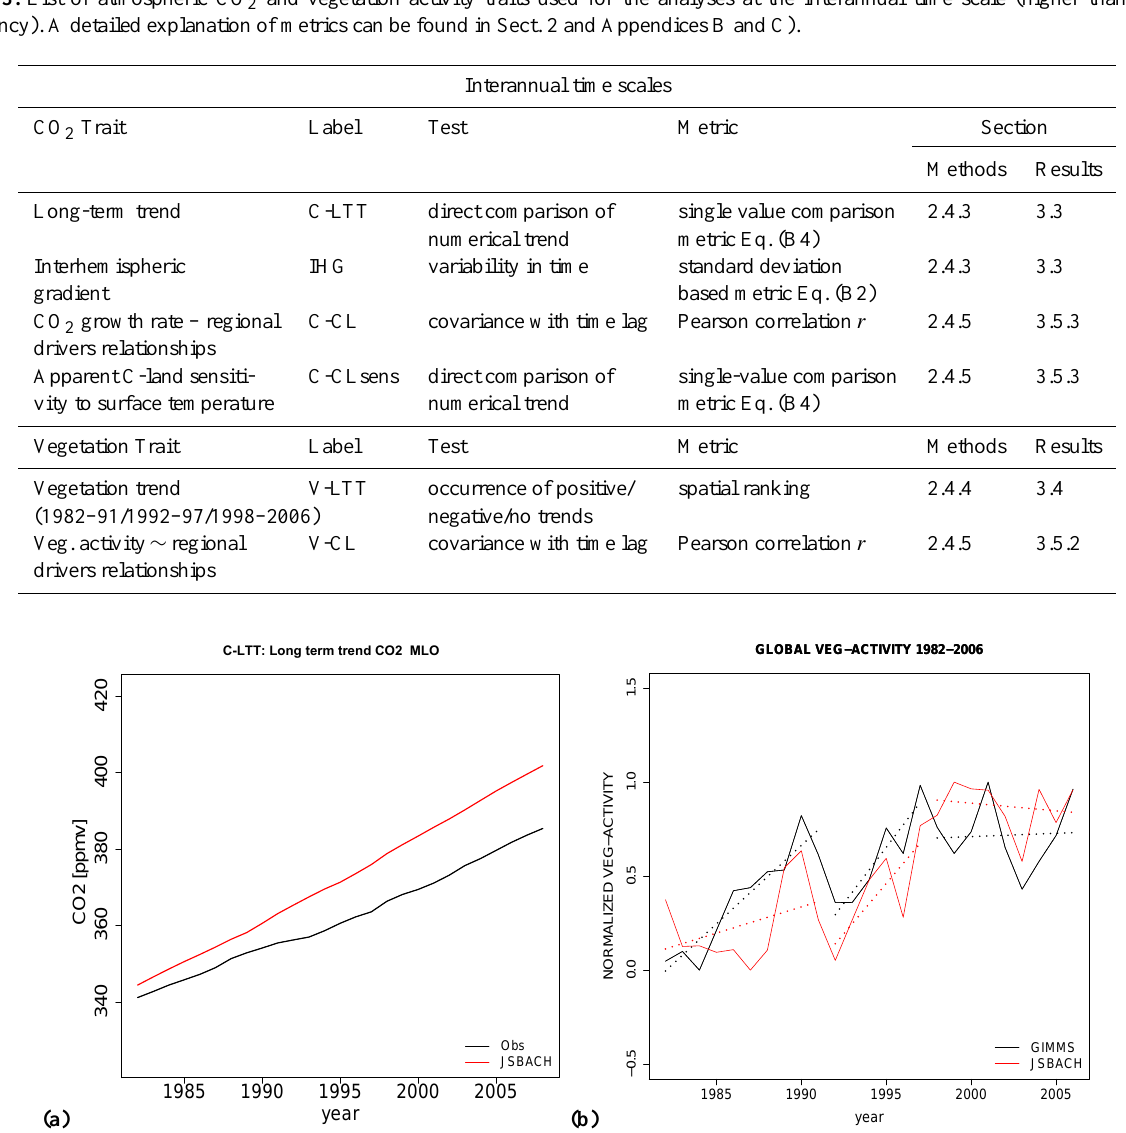
Fig. 6. (a) Long-term pattern of atmospheric CO 2 at the station of Mauna Loa (MLO); (b) normalized annual values of vegetation activity (excluding tropical, desert, and ice areas) for GIMMS-NDVI and modelled FAPAR. Period of reference 1982–2006. Dotted lines represent the linear trend computed on the normalized data (qualitative